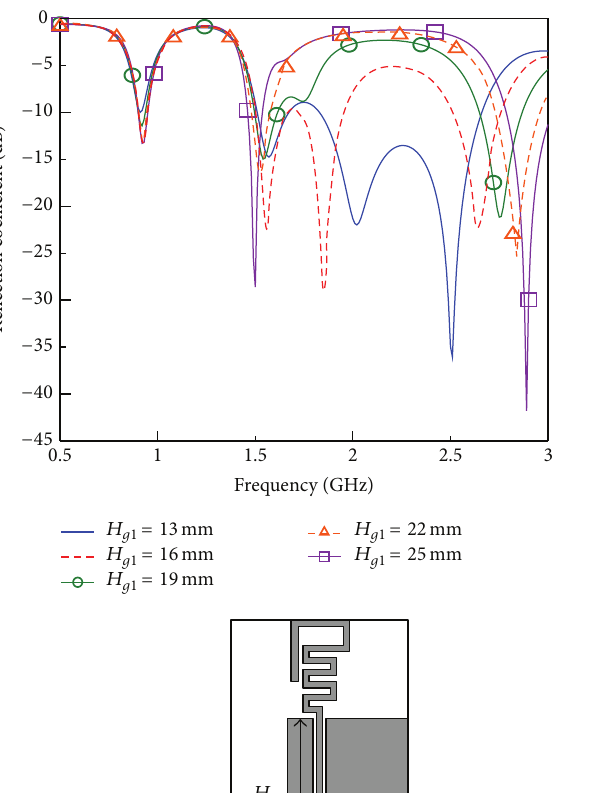
Figure 5: Comparison of simulated reflection coefficients of the proposed antenna with various 𝑊 𝑔1